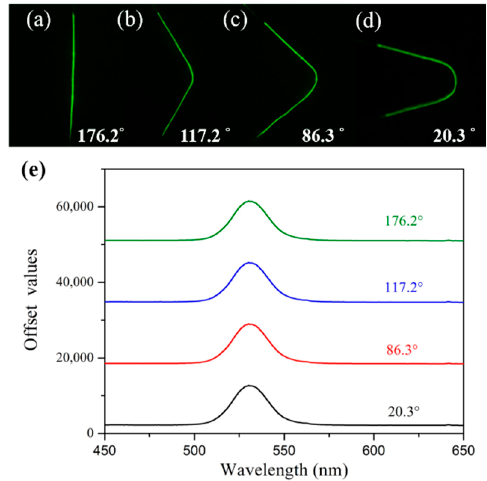
Figure 4. ( a – d ) The dark field images of the corresponding bended sensor. ( e ) The PL spectra corresponding to different bending angles.